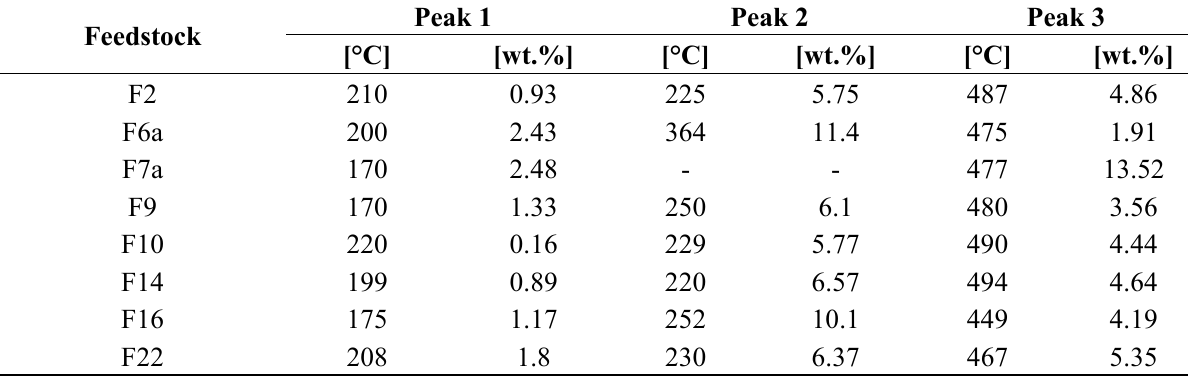
Table 4. Water debinded feedstock thermal degradation peaks in percentage of weight